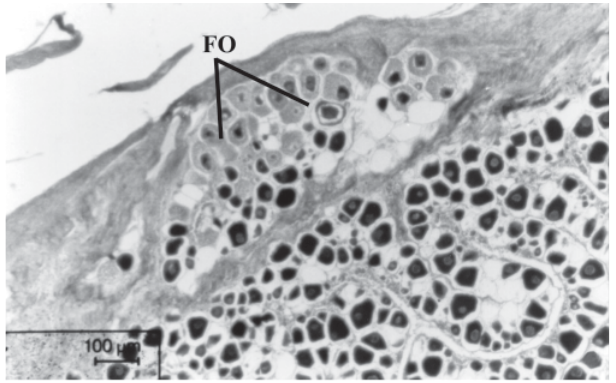
Fig. 7. Transverse section of a spent ovary of Mycteroperca bonaci showing oocytes in reabsorption (OR). Stain: H. E.